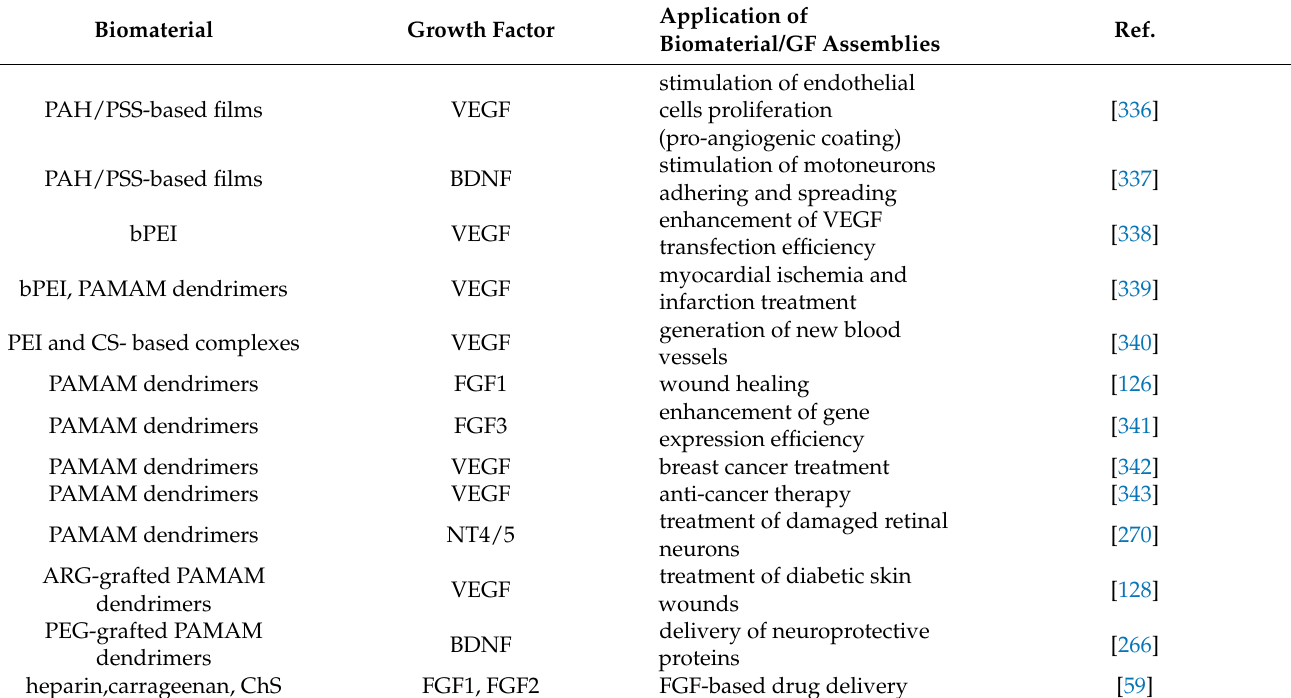
Table 6. The applications of the different biomaterials with attached/incorporated growth